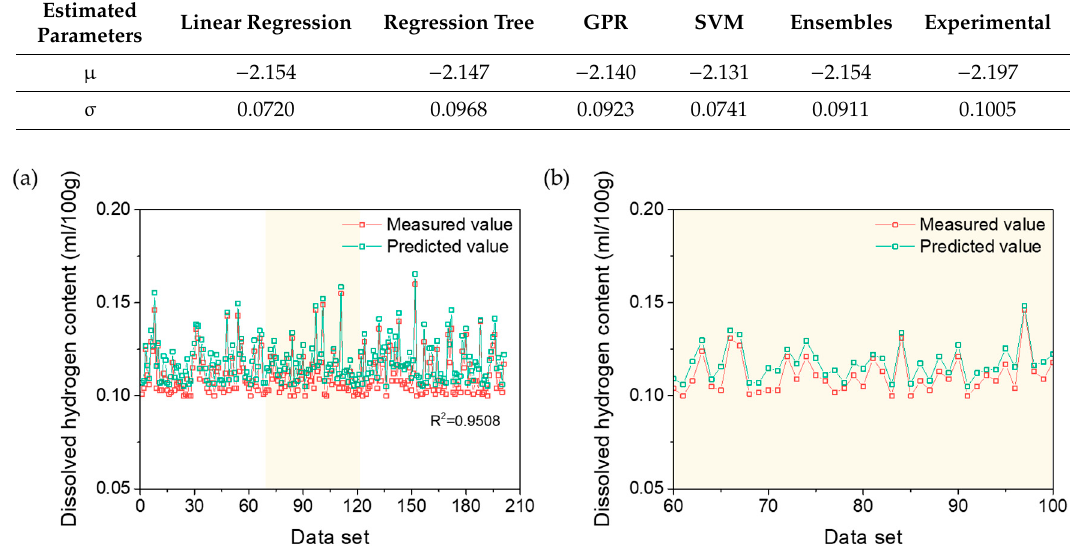
Figure 8. ( a ) The comparison of measured values by experiment versus predicted values by GPR